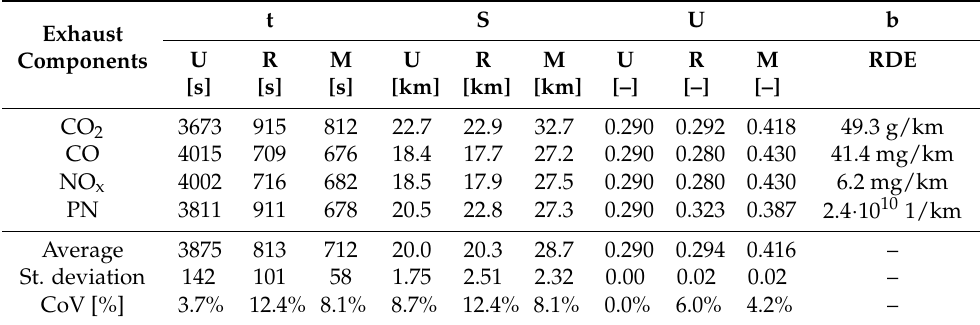
Table A4. Road emissions for the RDE test (assuming constant exhaust emission intensity)—output data obtained from the algorithm and the proposed values for the generalized test (Vehicle